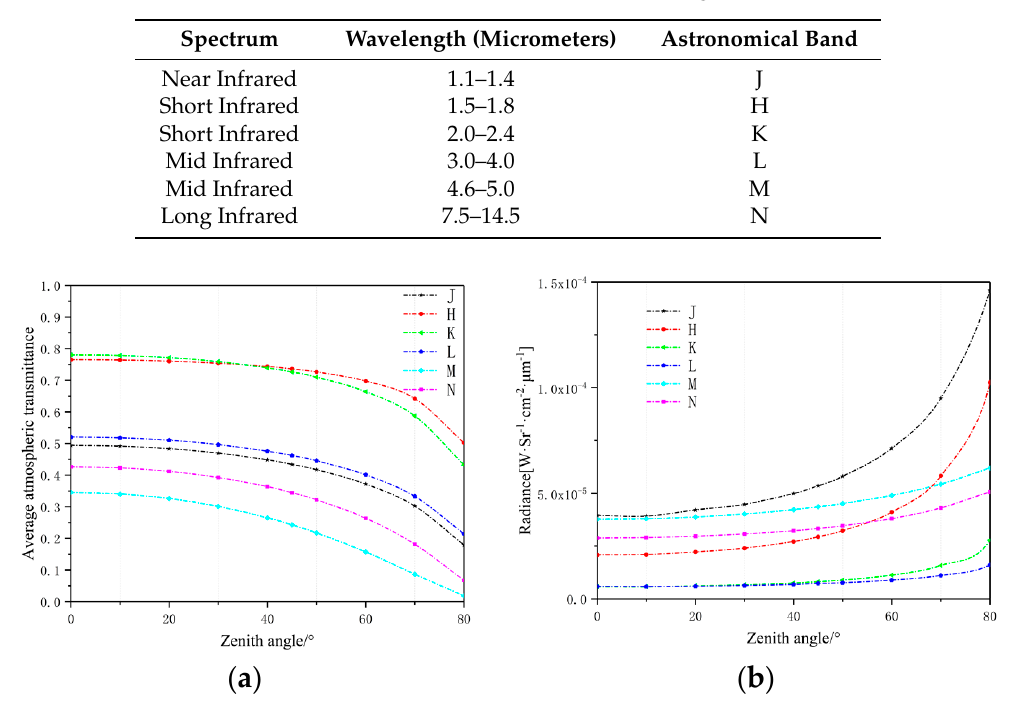
Figure 2. Average transmittance and sky radiance of infrared band with the Mid-Latitude Summer model at a different Zenith angle: ( a ) Atmospheric transmittance trend of each infrared band at different Zenith angles; ( b ) The radiance sky radiance trend of each infrared band at different Zenith angles. The model was run for an observer at 43.85 latitude and 125.4 longitude in the Changchun area. The phase angle of the sun was set at 60 degrees, and the target-included angle (the sun-target-Earth angle, where the vertex is the target) was larger than 100 degrees [12]. In this case, the direct light of sun exposure to the telescope could be neglected.